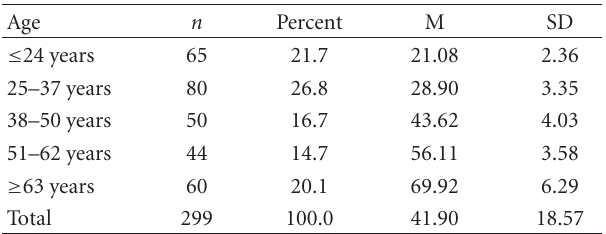
Table 1: Age categories and descriptive